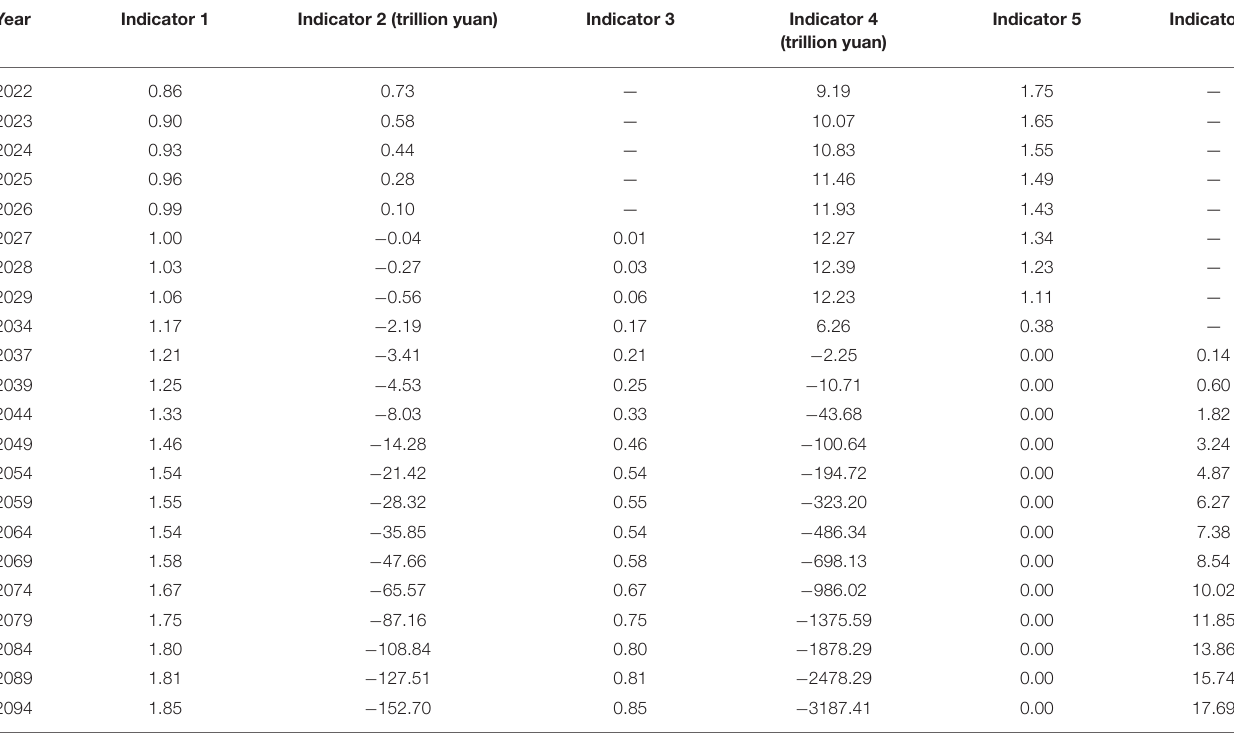
TABLE 1 | Fund reserve status under fixed parameter value scenario.